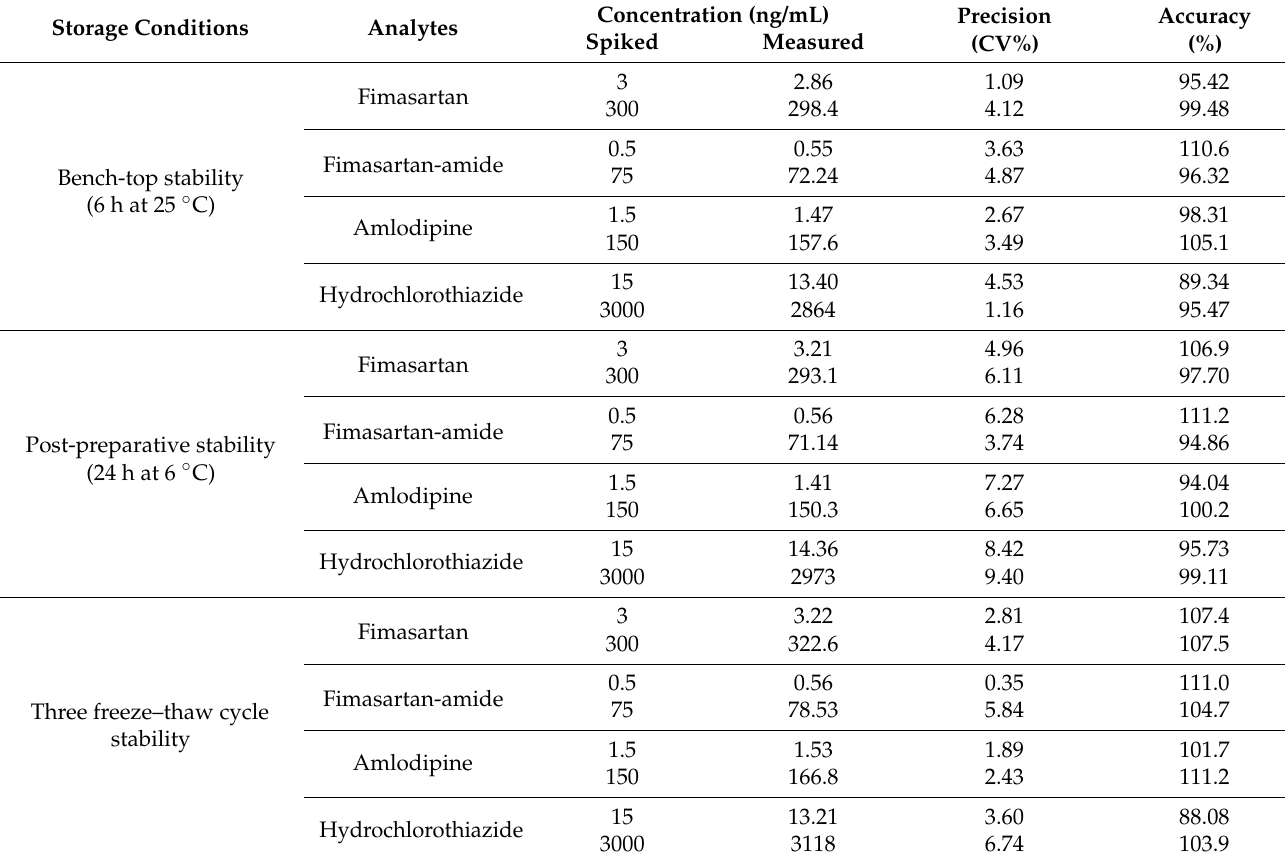
Table 4. Stability of fimasartan, fimasartan-amide, amlodipine, and